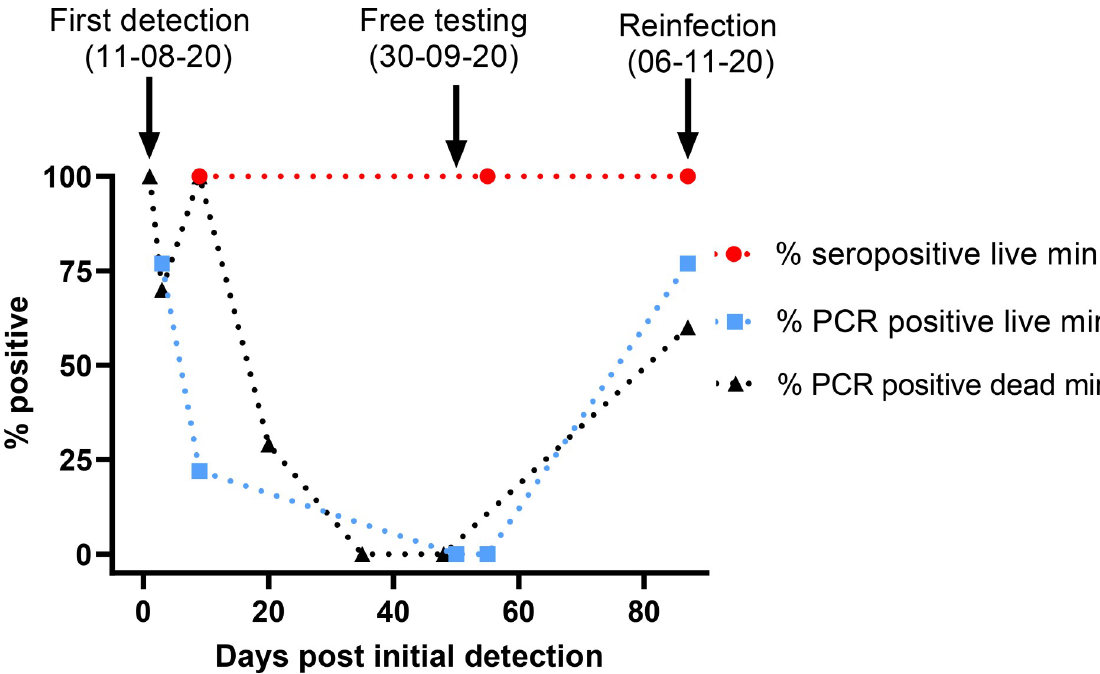
Fig 1. Timeline for infection of mink on Farm 4. The percentage of live and dead mink assayed by RT-qPCR that tested positive is shown throughout the period of August to November 2020, together with the proportion of live mink that tested positive by ELISA for anti-CoV-2 antibodies. The numbers of animals tested on each date are shown in Table 1. Dotted lines have been used to connect the data points for clarity but should not be used to infer intermediate percentage levels.